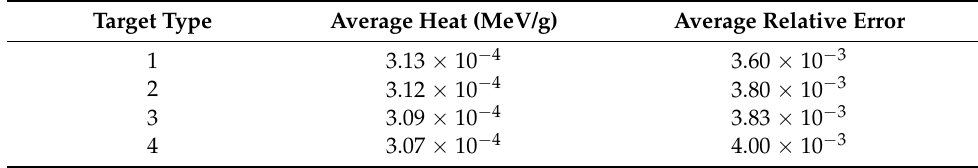
Figure 5. Comparative 239 Pu levels in targets with varying amounts of Ce. The heating tallies of the four target types is given in Table 3. Table 3. Results of F6 heating tallies for 4 target types.